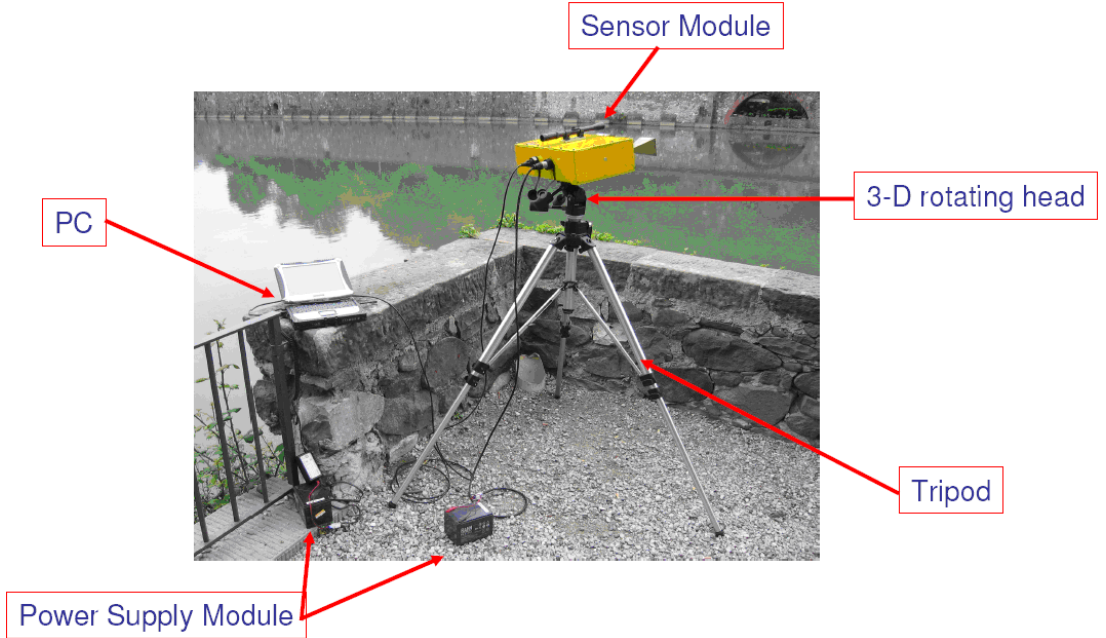
Figure 1. View of the microwave interferometer (IDS, model